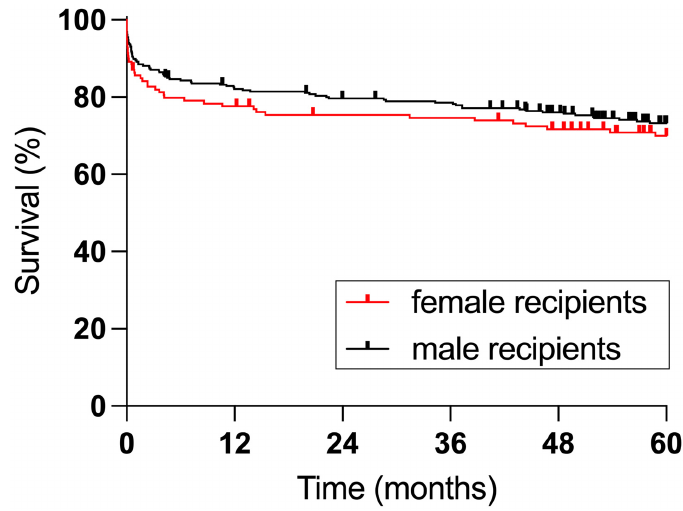
Figure 1. Survival of female and male recipients ( p = 0.5665).